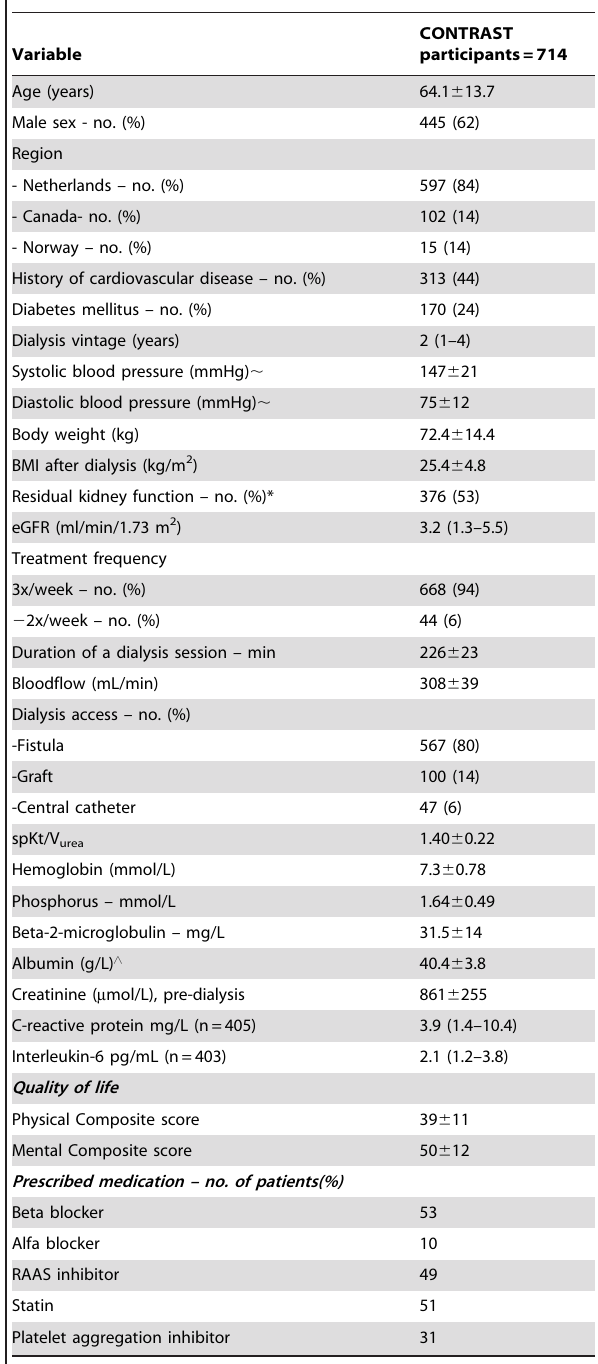
Table 1. Baseline characteristics of the CONTRAST